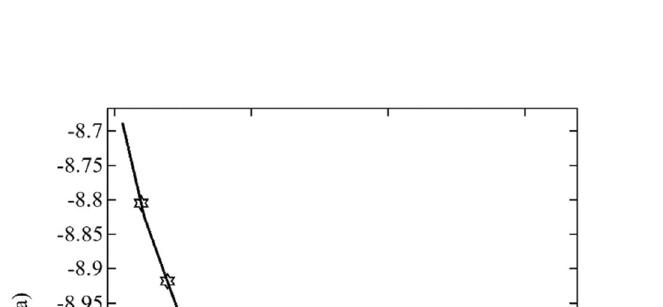
Figure 4. The meshing procedure of the finite element method in the 3-dimensional annulus.